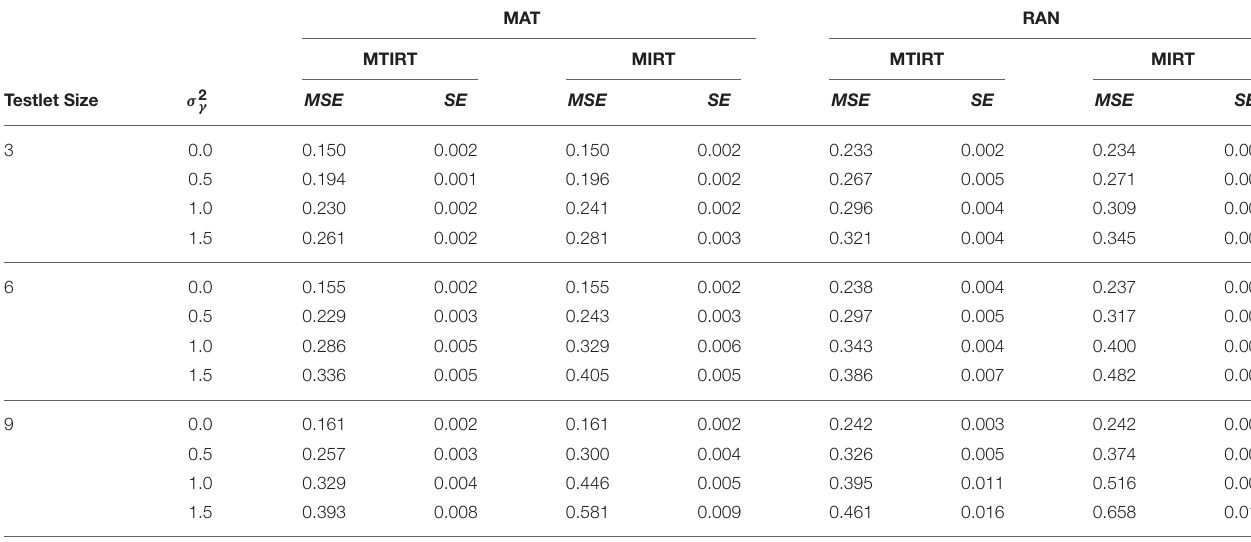
TABLE 3 | Average mean square error ( MSE ) of the ability estimates for MAT and RAN under the MTIRT and the MIRT model for different testlet sizes and different testlet effect variances ( σ 2 γ ). MAT RAN MTIRT MIRT